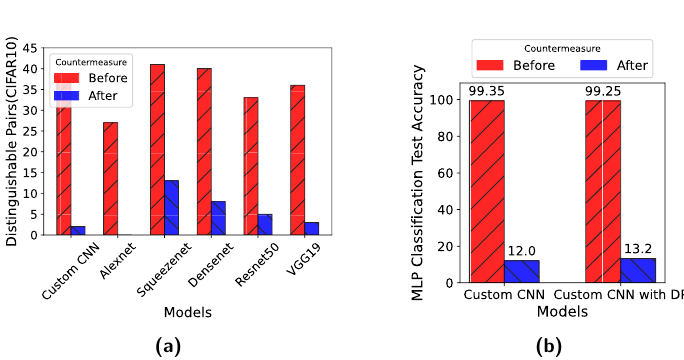
Figure 15: (a)Number of class pairs (out of 45) distinguishable by all CNN models trained with differential privacy before and after implementing the countermeasure (CIFAR10) (b)Accuracy of MLP model using inference time dataset of Custom CNN